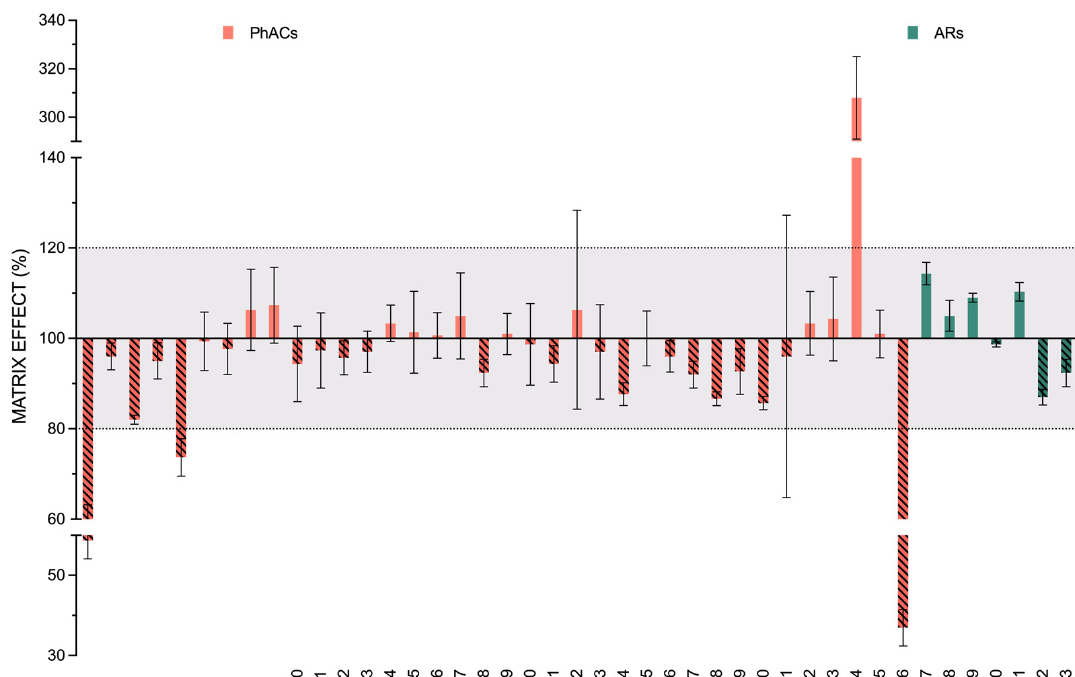
Figure 2. Matrix effect of the ARs and PhACs in the soil used for the validation process. Bars represent the mean recoveries and the SD of the 43 analytes. PhACs (orange) and ARs (green) are presented according to their number in Table 1. The suppression has been indicated with an oblique dashed pattern.